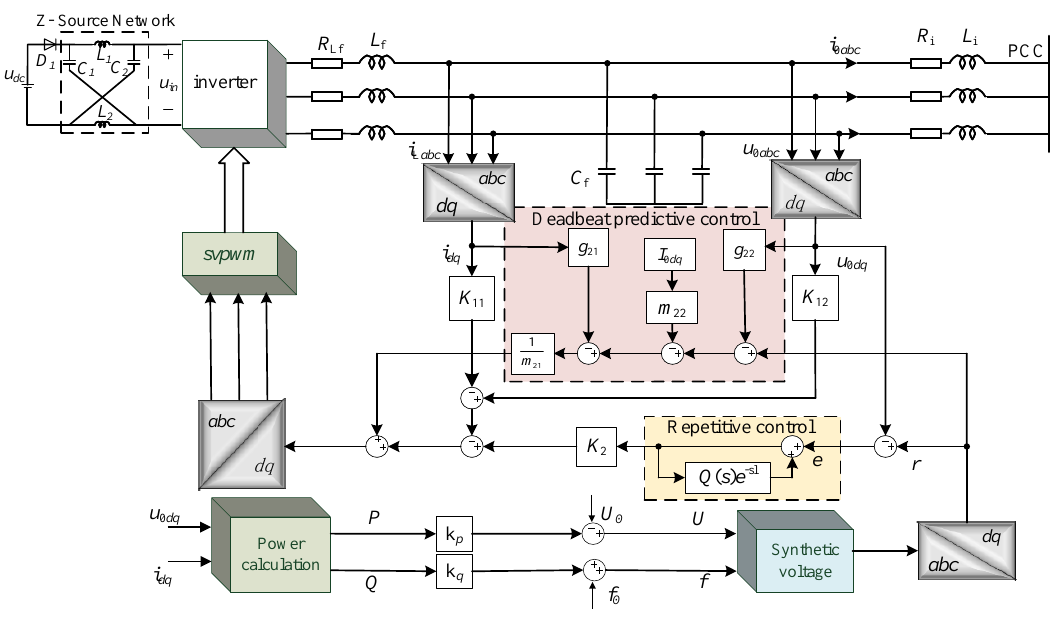
Figure 6. System control block